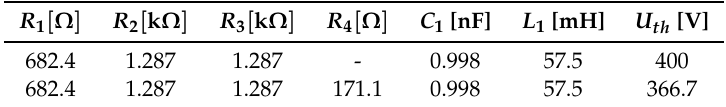
Figure 3. Average of five current measurements of the first pulse at 1 Hz (yellow) and 4717 Hz (green) repetition frequency. ( a ) Modeled current (red), optimal circuit parameter values were determined for each applied voltage separately for 4717 Hz pulse repetition rate; ( b ) Modeled current (red), optimal circuit parameter values were determined with the LSE method, the cost function included all three currents at different voltages for pulse repetition rate 4717 Hz. Table 2. Optimal values of electronic components for the single positive monopolar pulse model are presented in the first line and for multiple monopolar pulse model in the second.